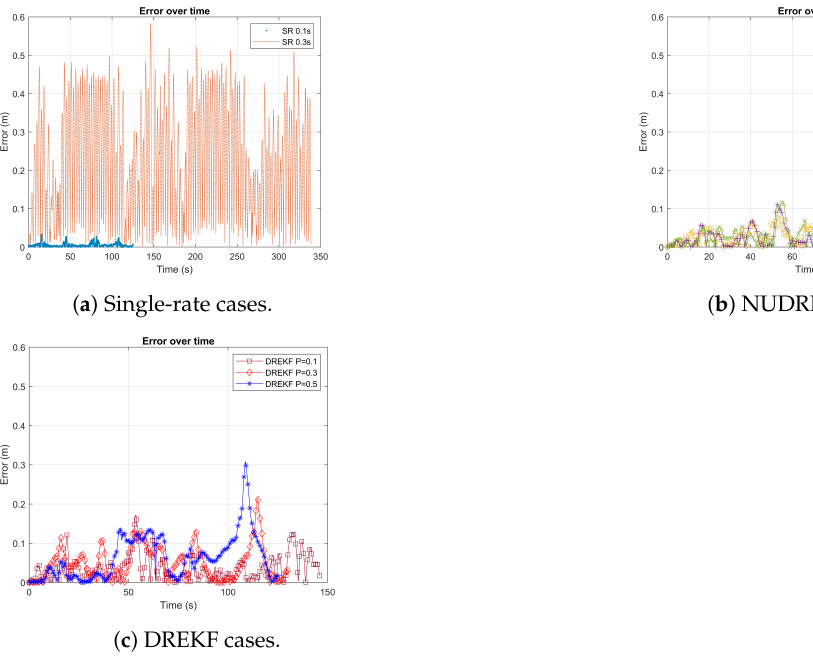
Figure 16. Path-tracking trajectory error over